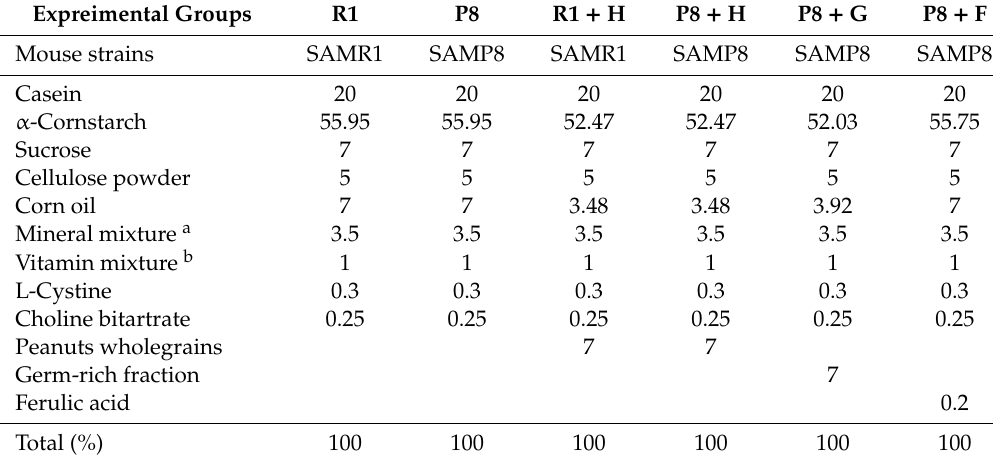
Table 1. Composition of diet